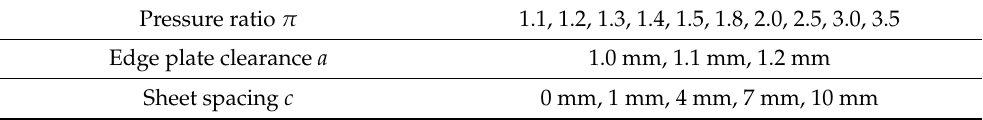
Table 1. All experimental working